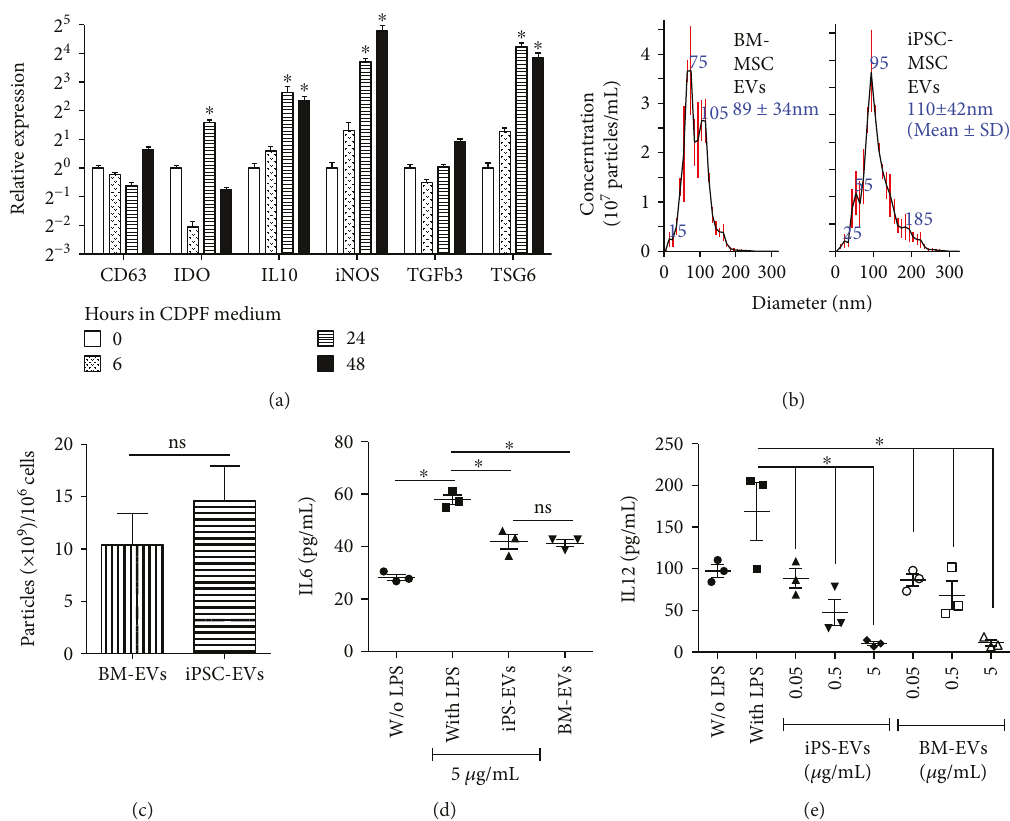
Figure 2: Optimization of iPSC-MSC culture conditions for EV preparation and characterization of EVs. (a) E ff ects of incubation in CDPF medium on the expression of biomarkers for anti-in fl ammatory and immunosuppressive properties of MSCs in iPSC-MSCs as determined by qRT-PCR. (b, c) Size distribution and yields of EVs derived from BM-MSCs and iPSC-MSCs measured by NanoSight nanoparticle tracking analysis. (d, e) E ff ects of two types of MSC EVs on cytokine expression by LPS-stimulated mouse splenocytes as determined by ELISA. n = 3 ; ∗ P < 0 05 ; ns: not signi fi cant.